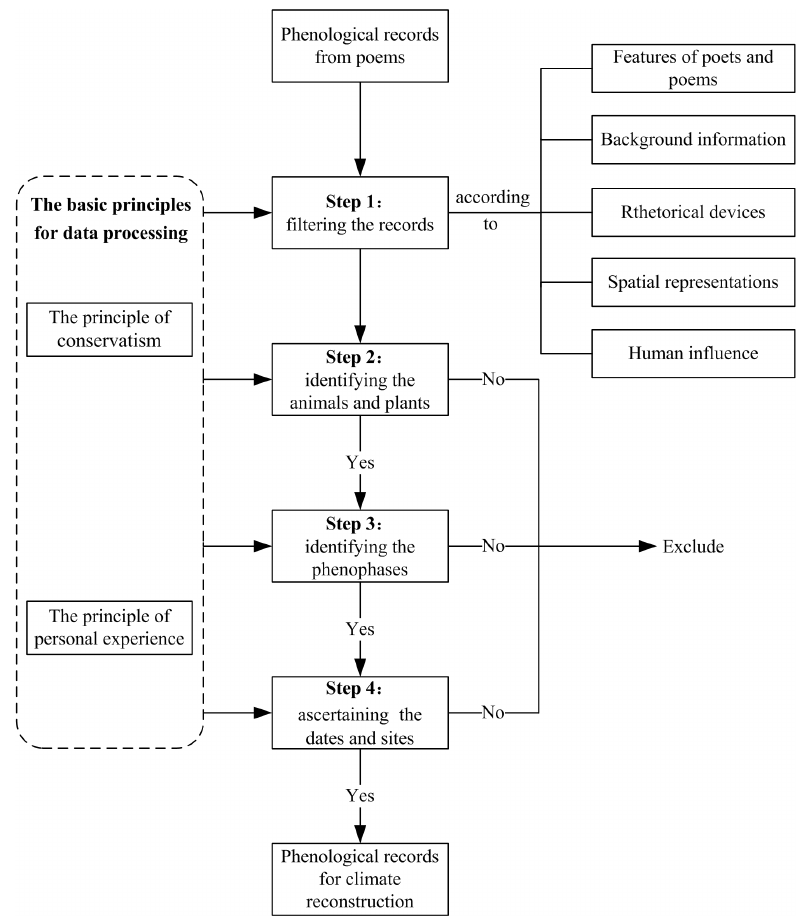
Figure 1. Processing steps of phenological records in poems for climate